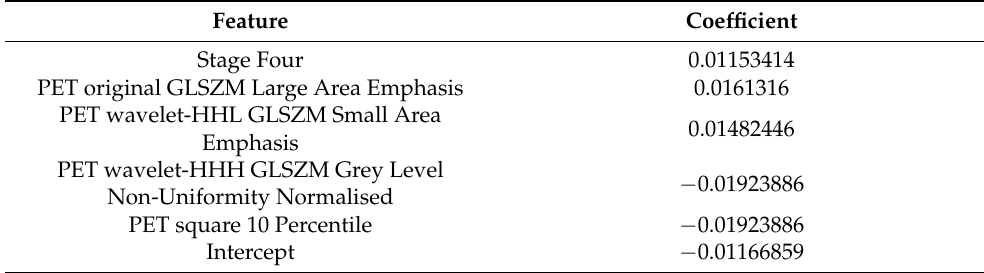
Table 6. Confusion matrix for the threshold of 0.5.